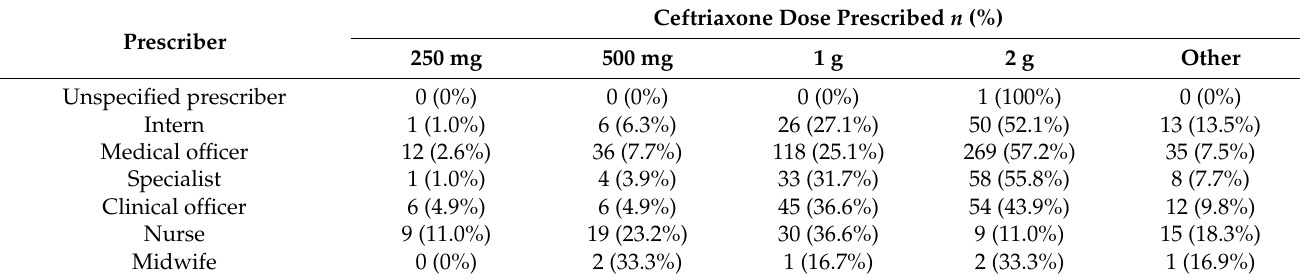
Table 5. The doses of ceftriaxone prescribed by the different categories of prescribers ( n = 882).